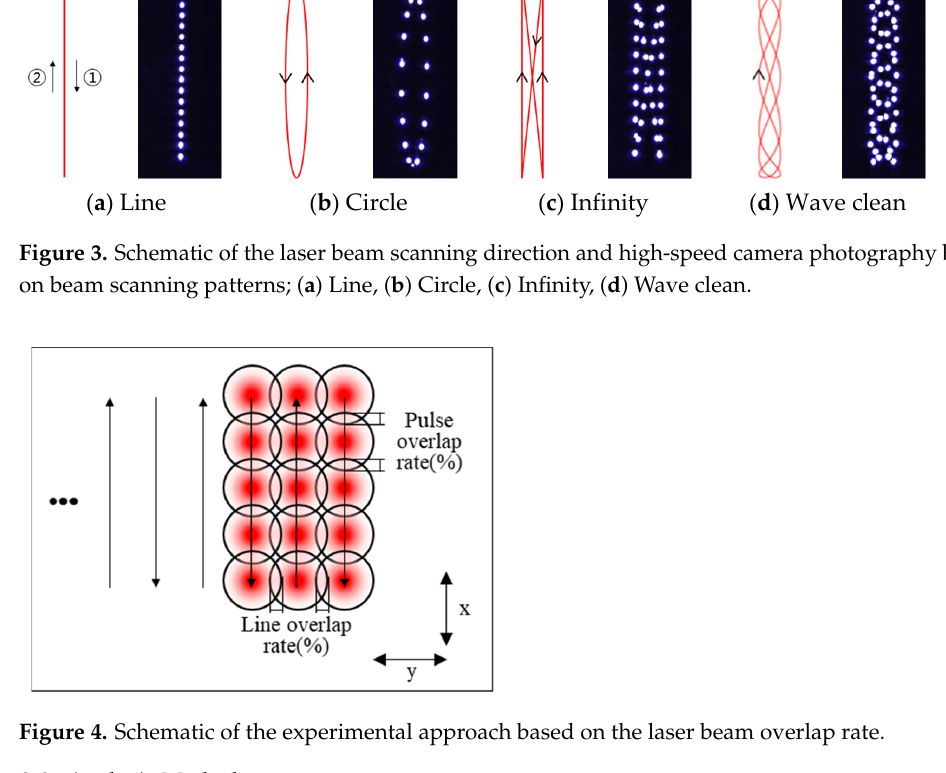
Figure 2. Experimental setup for the laser cleaning experiment using a portable fiber laser cleaning system.